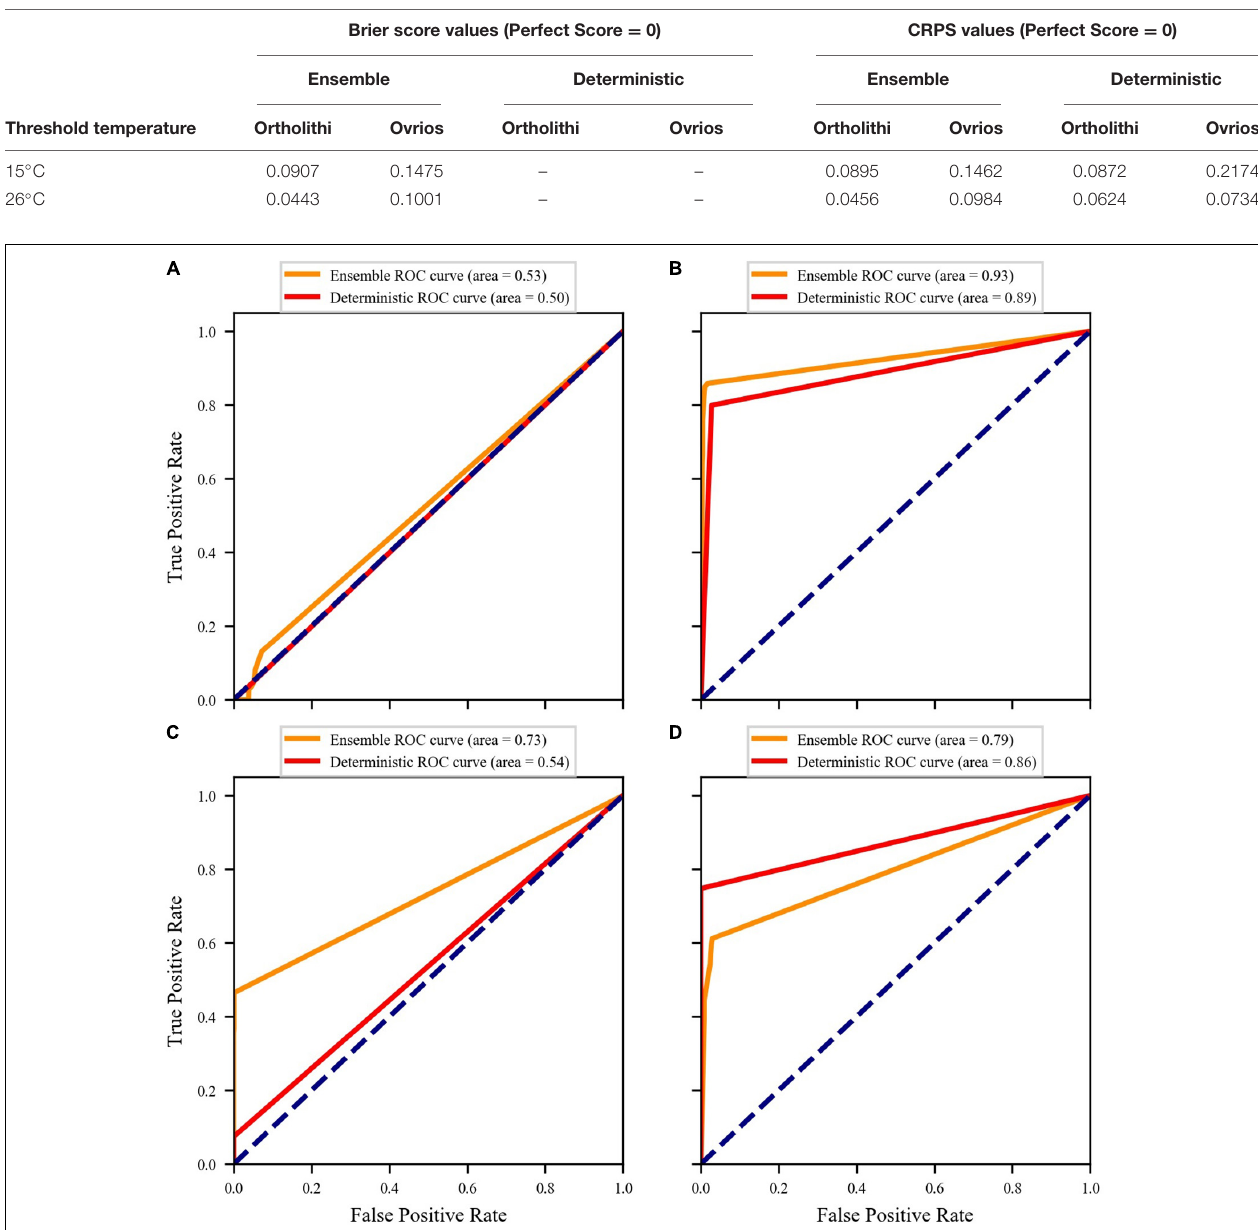
TABLE 4 | Brier score and Continuous Ranked Probability Score (CRPS) values computed for two stations.